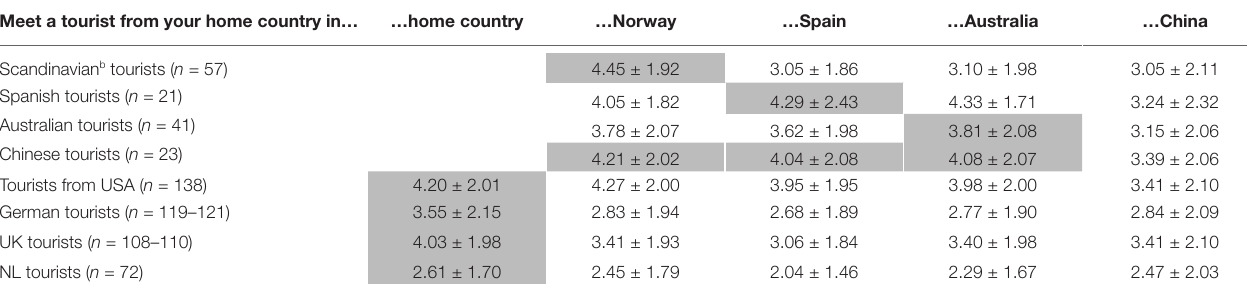
TABLE 2 | Interestingness a of meeting a tourist from China in various countries [scale: 1 (not interesting) – 7 (very interesting), mean scores, ±SD]. Meet a tourist from your home country